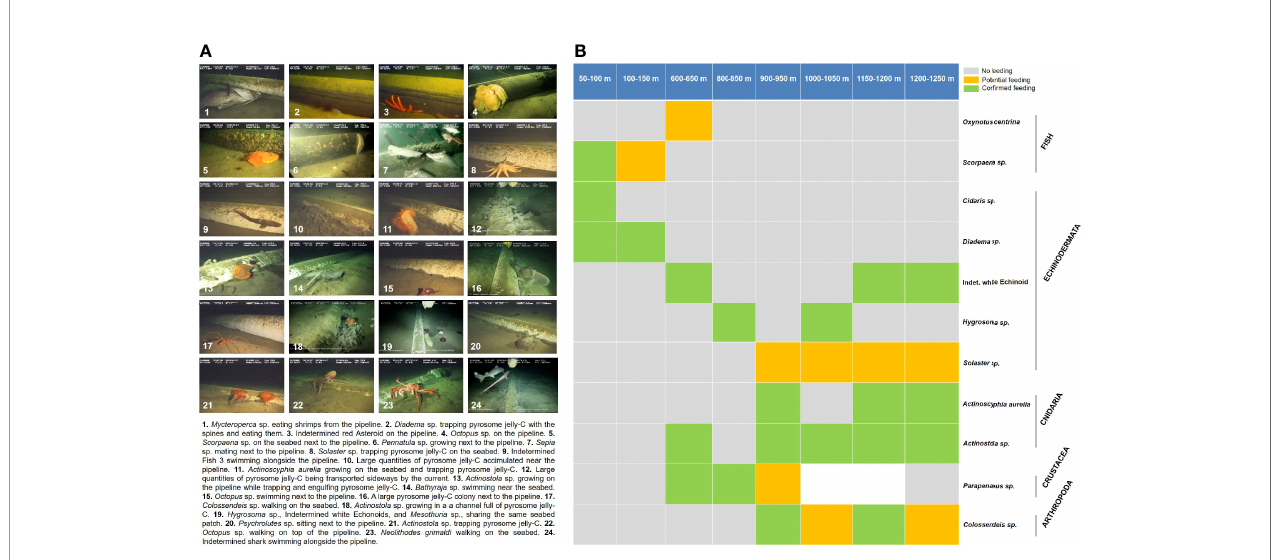
FIGURE 5 | Remotely operated vehicle (ROV) survey photo summary and feeding events. (A) Photo summary of the benthic surveys including descriptions of interesting ecological events. (B) Details of the feeding events observed in the surveys along the bathymetric gradient. “ No feeding ” means the organism was not seen interacting with the jelly-C, “ potential feeding ” means the organism was seen manipulating the jelly-C but not feeding, and “ con fi rmed feeding ” means the organism was seen actively feeding, biting, or nibbling the jelly-C. A summary and the complete surveys are provided in Videos S1 and S2 . A full taxonomic list of organisms from this study is available in Table 2